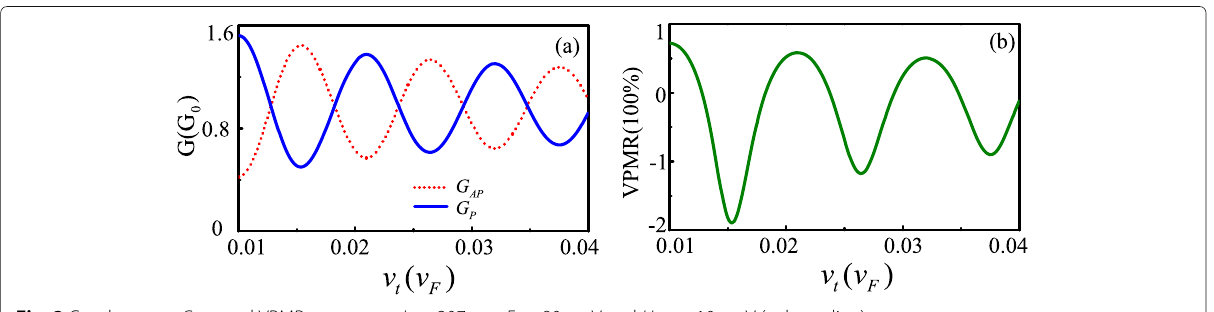
Fig. 2 Conductance G P , AP and VPMR versus v t at L = 207 nm, E = 80 meV and U = − 10 meV (color online)